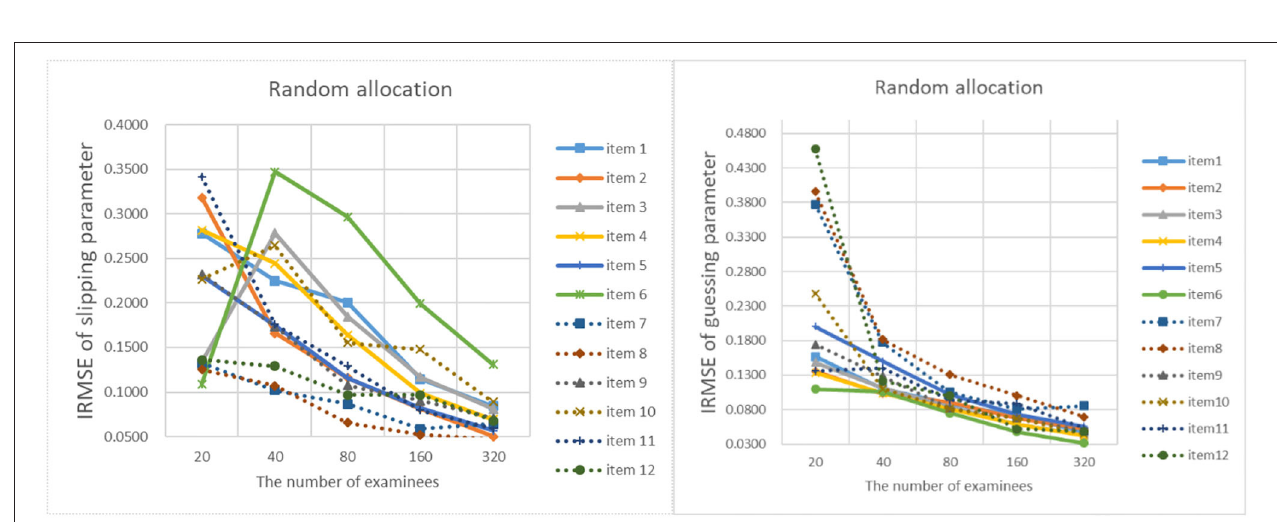
FIGURE 14 | The IRMSE of the random allocation